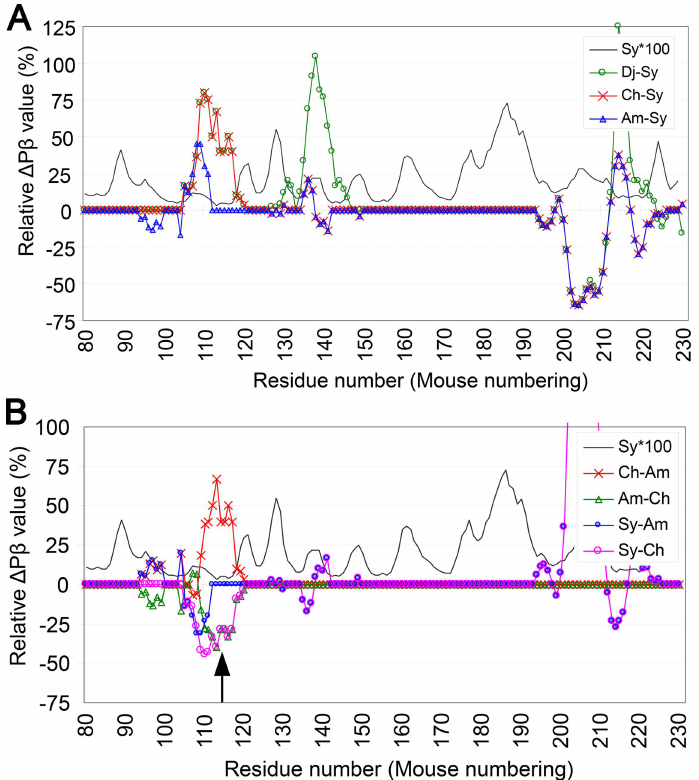
Fig 6. Relative Δ P β graphs of transmissions of Sc237 among various hamster species visually aid interpretation of the results. A . Δ P β graphs of PrPs of varioushamster species relative to that of Syrian hamster for the transmission of Sc237 from Syrian to other hamster species. The reference species are the donorsof the transmissionsand the former speciesare the recipients. Sy, Syrian hamster. Ch, Chinese hamster. Am, Armenianhamster. Dj, Djungarianhamster. B . Δ P β graphs for back-transmissions of Sc237 from different hamster species to Syrian hamsters, and for transmissionbetweenArmenian and Chinese hamsters. The upwardarrow indicatesthe position of the P β trough at residue